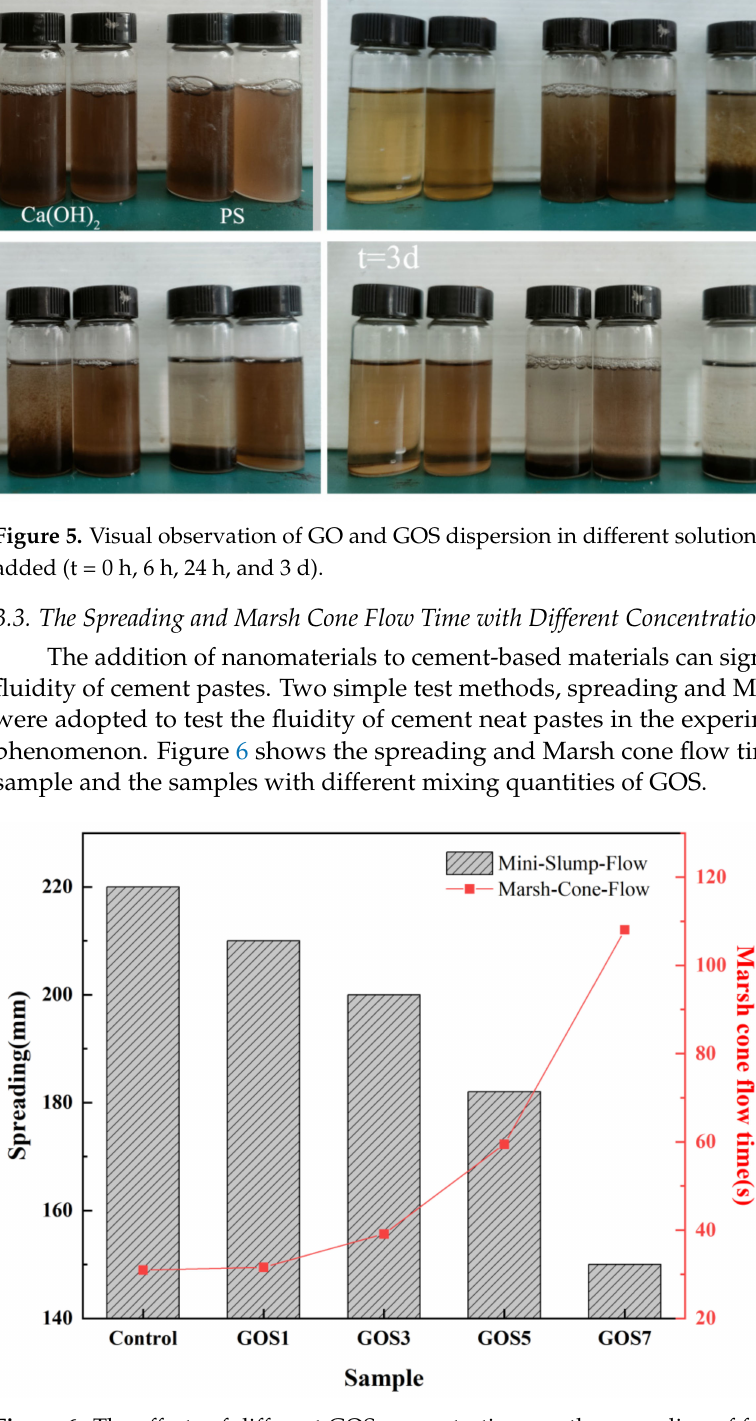
Figure 6. The effects of different GOS concentrations on the spreading of fresh cement paste and Marsh cone flow